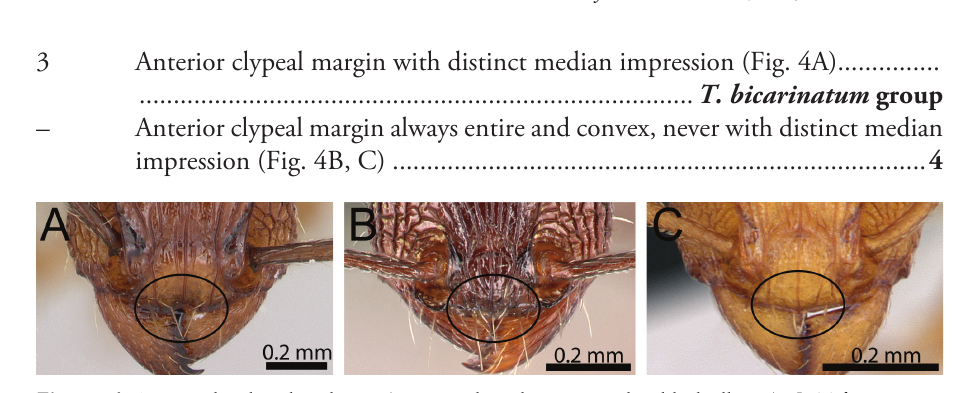
4 Propodeum armed with long to extremely long spines (PSLI 30–49), at least 2 to 3 times longer than metapleural lobes (Fig. 5A) ............... T. tosii group – Propodeum either unarmed (Fig. 5B), armed with small triangular teeth or denticles, or armed with medium-sized spines (Fig. 5C), propodeal spines at most only as long or weakly longer than metapleural lobes, more often pro- podeal spines distinctly shorter than metapleural lobes ............................... 5 5 Lateral portion of clypeus prominent, raised to a tooth or denticle in full-face view (Fig. 4B); propodeal spines medium-sized and spinose, approximately of same length as metapleural lobes (Fig. 5C) ........... T. sericeiventre group – Lateral portion of clypeus never modified as above (Fig. 4C); propodeum either unarmed (Fig. 5B) or armed with small triangular teeth or denticles that are shorter than metapleural lobes (Fig. 6E, F) ..................................... 6